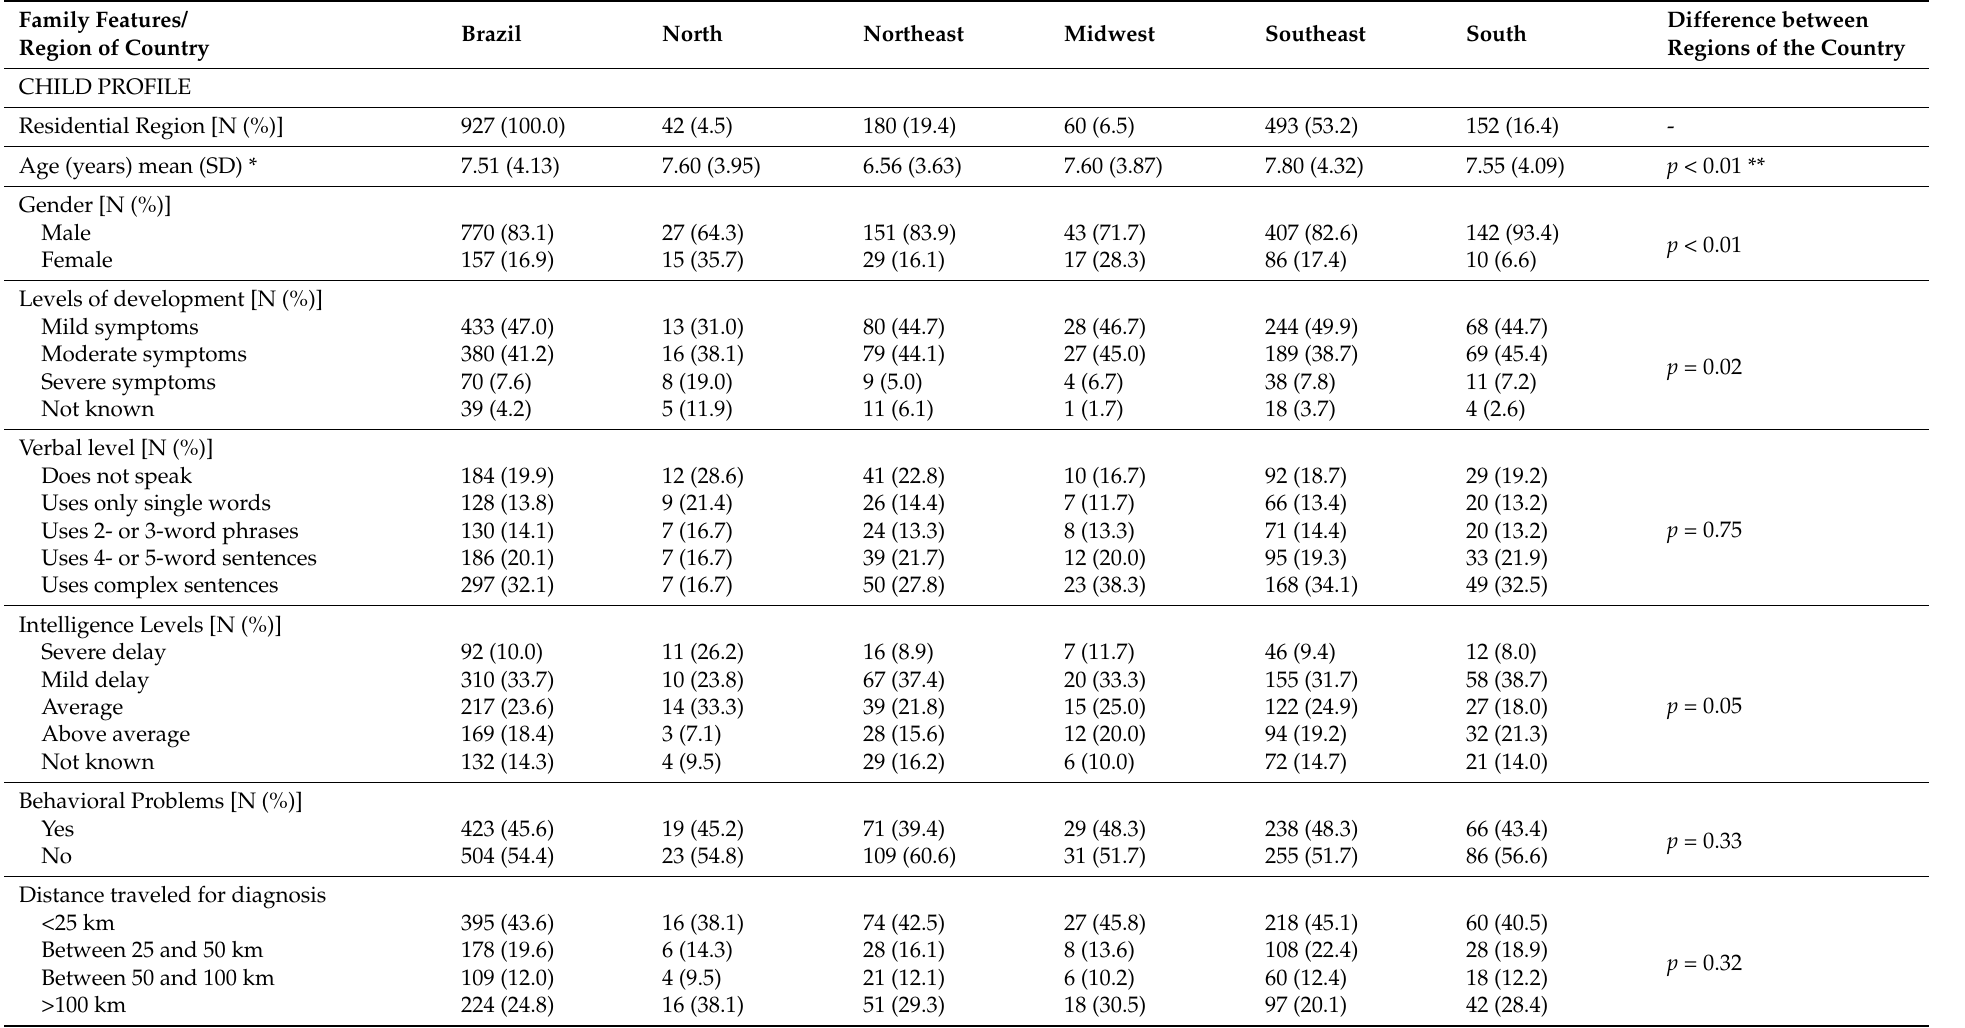
Table 1. Family sociodemographic characterization and clinical profile of children with ASD (N = 927). Family